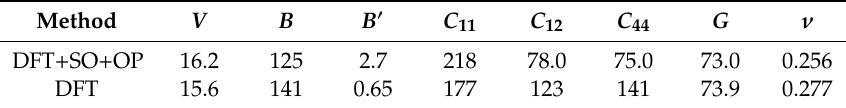
Table 1. Ground-state properties obtained from the full theoretical treatment (DFT + SO + OP) and for a treatment that ignores spin-orbit coupling and orbital polarization (DFT). The atomic volume ( V ) is given in units of Å 3 , while the bulk ( B ), shear ( G ), and elastic ( C ij ) moduli are given in units of GPa. The shear modulus is a Voigt–Reuss–Hill average and the Poisson’s ratio, ν , is obtained from B and G (see main